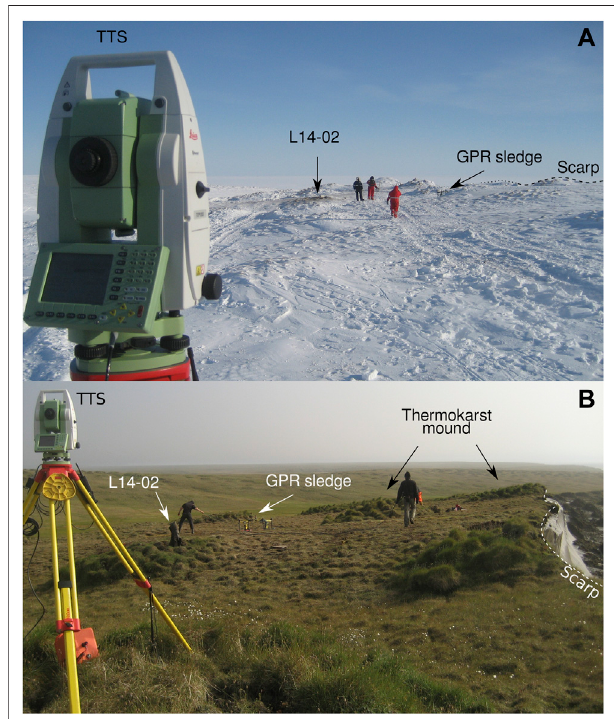
FIGURE 3 | Impression of survey conditions in (A) spring and (B) summer 2014. The scarp at the southern end of our survey area represents a sharp transition to a thermo-terrace ~7 – 15 m below. The coring site L14-02 (see also Supplementary Table S1 ) was covered by ourGPR survey in spring. The viewpoints of both photos are annotated in Figure 1